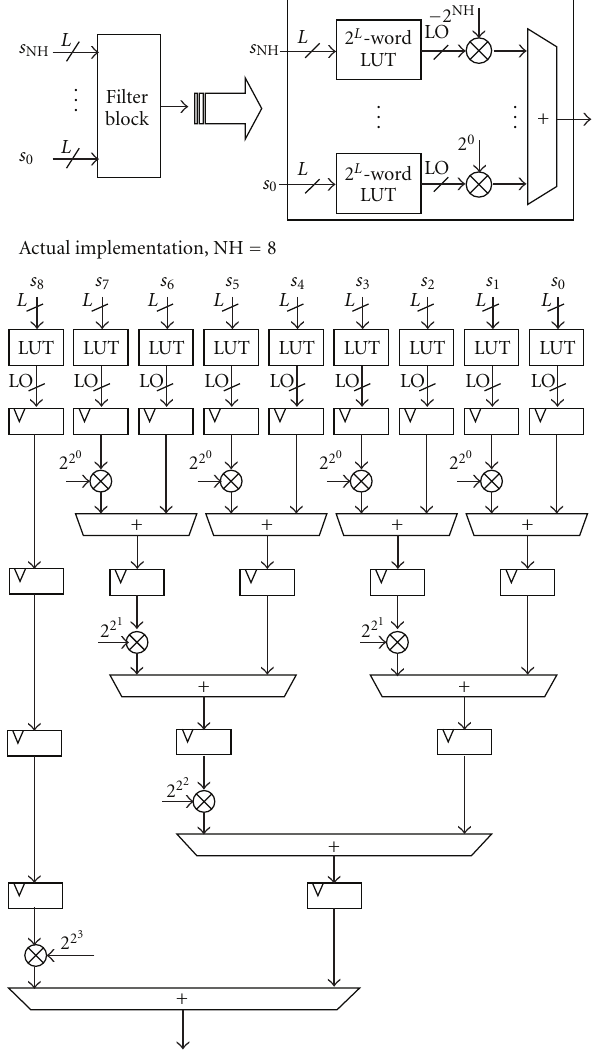
Figure 3: Filter block architecture. SYMMETRY = YES. Table 5: Reconfiguration time for both DPR system realizations. the 43 kb bitstreamcorresponds to coe ffi cient-only reconfiguration case. The 83 kb bitstream corresponds to full-filter reconfiguration.